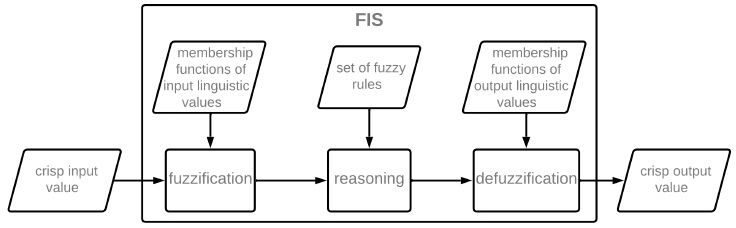
Figure 1. Schematic overview of the